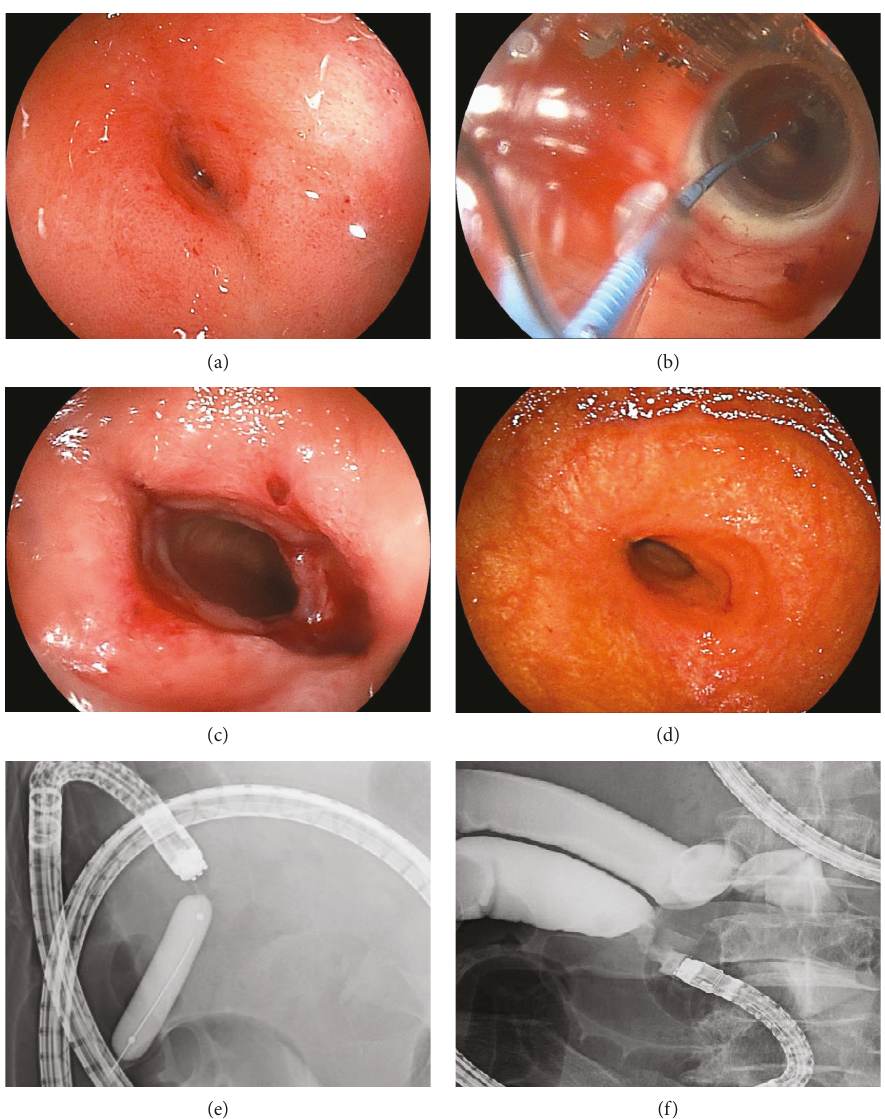
Figure 1: The endoscopic balloon dilation procedure. (a) Endoscopic imaging of a stricture due to scar after chemotherapy for malignant lymphoma. (b) Balloon dilation. (c) After dilation. (d) Endoscopic imaging of stricture after 5 times of dilation. (e) Contrast study of the stricture during dilation. (f) Contrast study of the stricture after